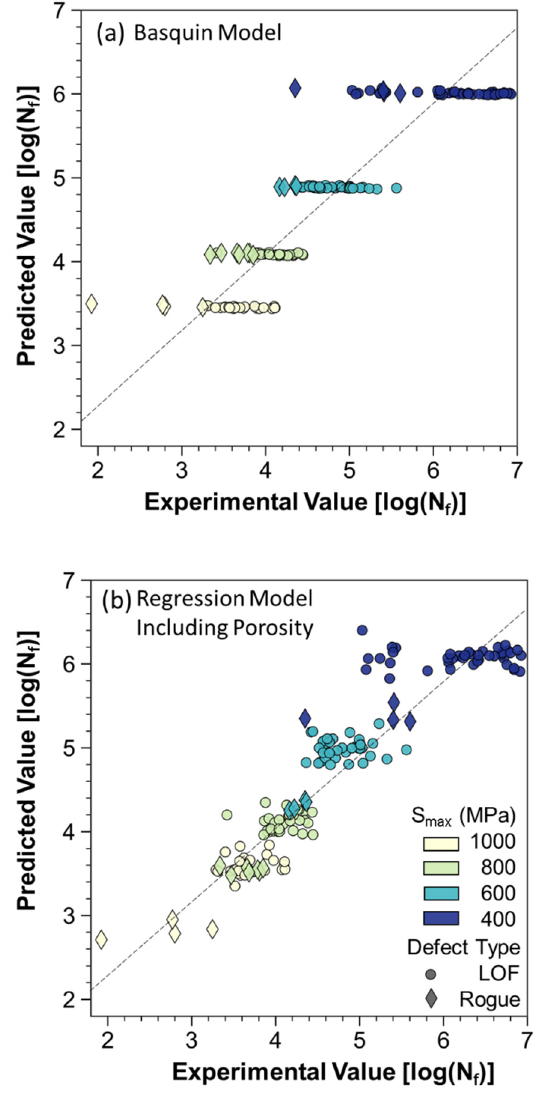
Figure 13. Comparison of predicted values against experimental values for ( a ) the Basquin model and ( b ) the linear regression model that accounts for porosity characteristics (Equation (5)).